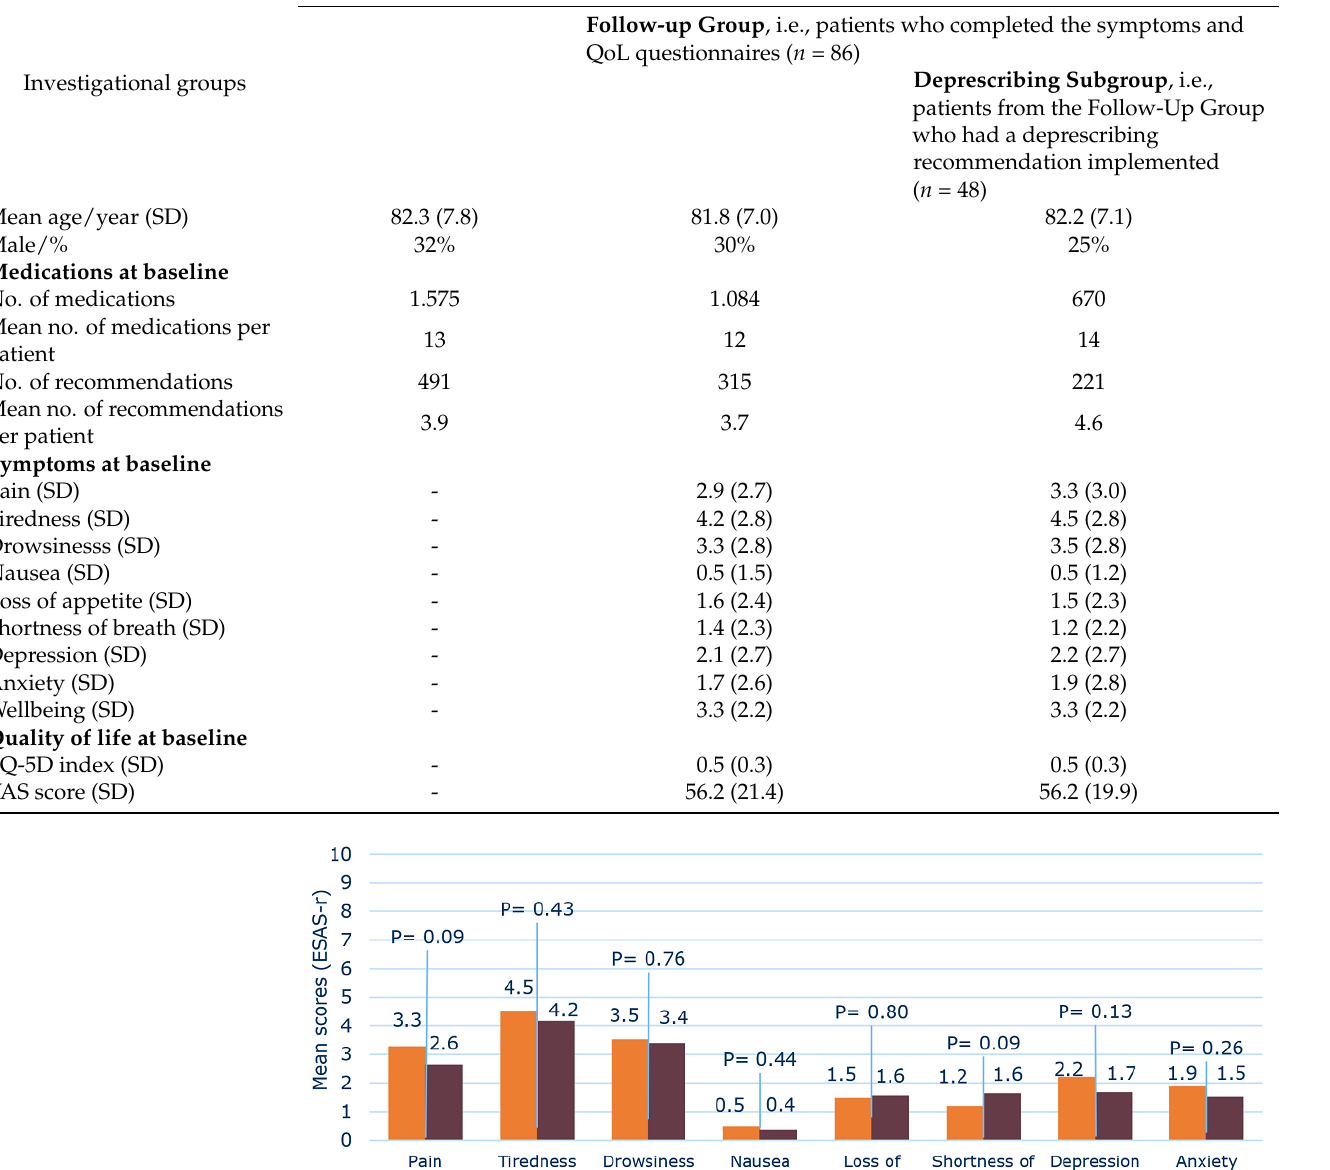
Table 1. Characteristics of the patients constituting the investigational groups—the Medication Review Group, Follow-Up Group and Deprescribing Subgroup—regarding age, gender, medication, and outcomes. The symptoms and quality of life (QoL) questionnaires were not completed by all patients belonging to the Medication Review Group, which is why this column is not completed (-).